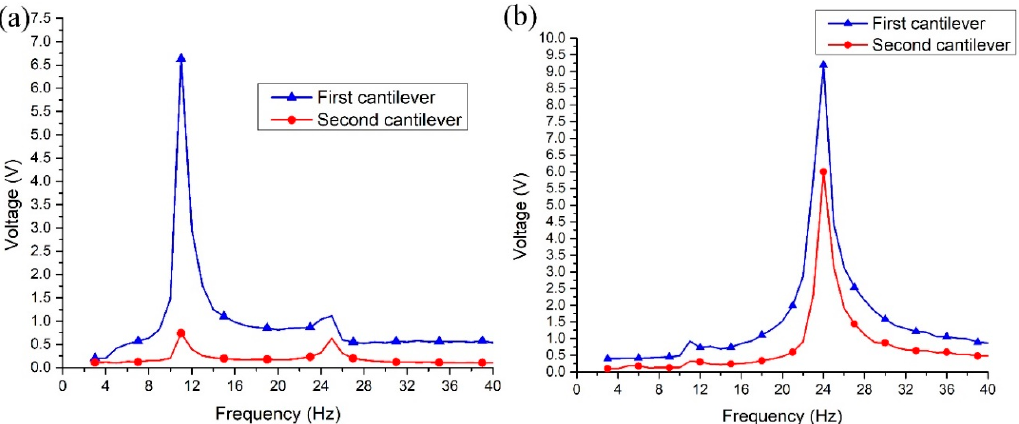
Figure 16. Measured open circuit voltage versus frequency when excitation direction is aligned with y axis ( a ) and z axis ( b ).